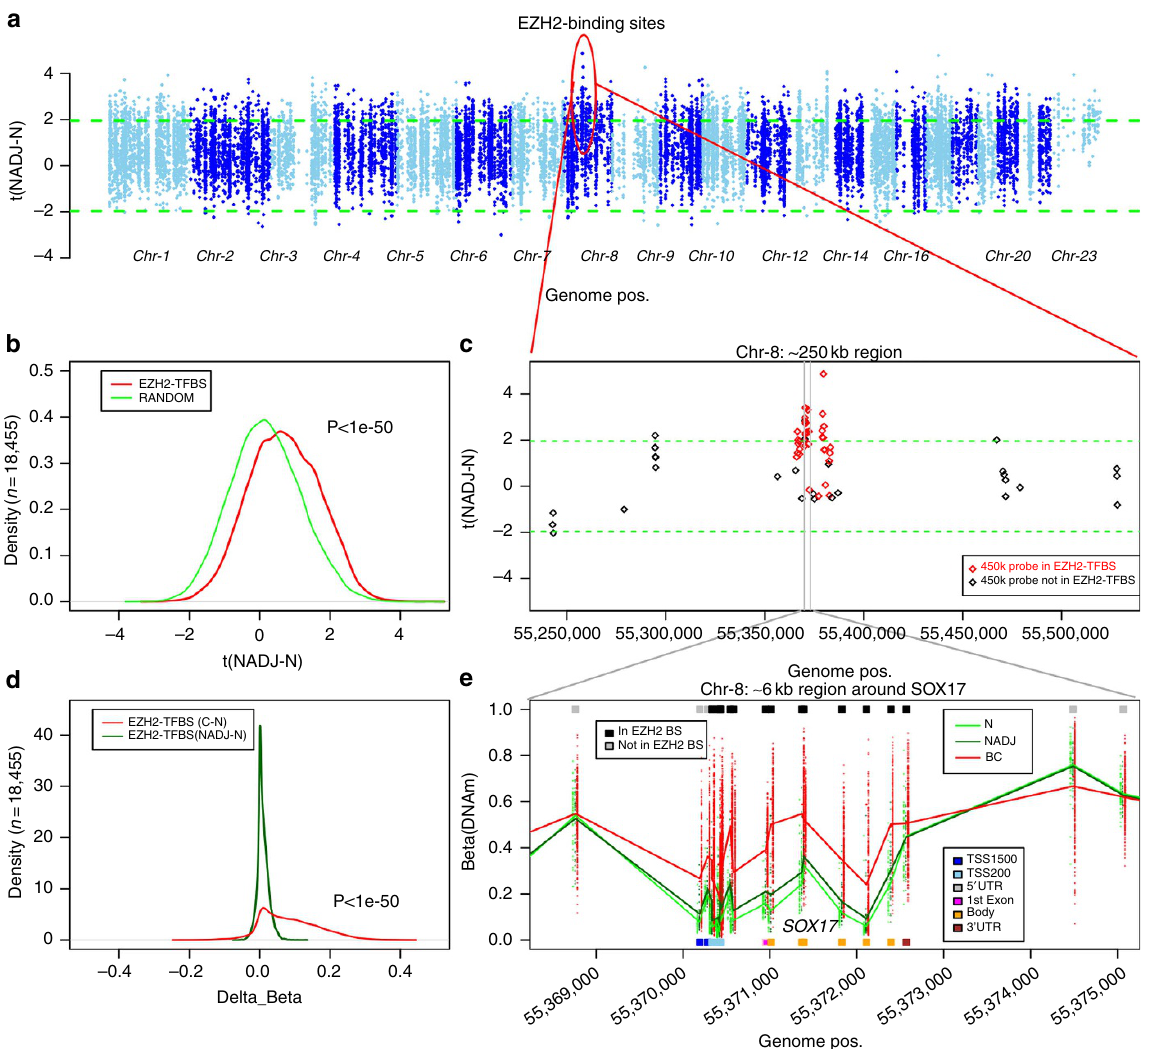
Figure 4 | Enrichment of EZH2 TF-binding sites among DNA methylation field defects. ( a ) Manhattan type plot of the t -statistics of differential DNA methylation between normal adjacent (NADJ) and normal breast tissue (N; y axis: t(NADJ-N)) of 450k probes mapping to EZH2-binding sites (18,455 sites). Green dashed lines represent the lines corresponding to P ¼ 0.05. Positive values indicate larger DNAm in NADJ tissue compared with normals. ( b ) Density distribution of the t -statistics of differential methylation between normal adjacent (NADJ) and normal breast tissue (N) of 450k probes mapping to EZH2-binding sites (red) compared with a randomly chosen set (green). P -value is from a Wilcoxon rank sum test. ( c ) Zoomed in version of a focusing on a 250-kb region on chromosome-8, but now showing all 450k probes in the region, with those mapping to EZH2-binding sites indicated in red. ( d ) Comparison of the density distribution of average differences in DNA methylation ( x axis: delta_Beta) for the 18,455 probes mapping to EZH2-binding sites (EZH2 TFBS) between cancer and normal adjacent tissue (C-N), to the corresponding differences between normal adjacent and normal tissue (NADJ-N). Thus, positive delta_Beta values correspond to higher DNAm values in cancer compared with normal (C-N), or to higher DNAm values in NADJ tissue compared with normal (NADJ-N). ( e ) DNA methylation beta values for all samples and probes in an B 6-kb region, centred around the PRC2 target, SOX17 . The lines represent the mean DNAm values in each group: normal (N), normal-adjacent (NADJ) and breast cancer (BC). Probes/CpGs have been annotated according to whether they fall in a EZH2-binding site, and which gene region they map